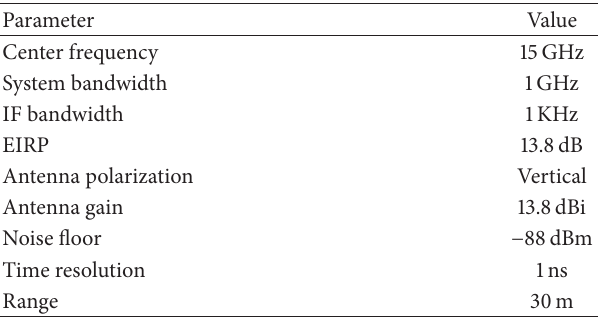
Table 1: Measurement